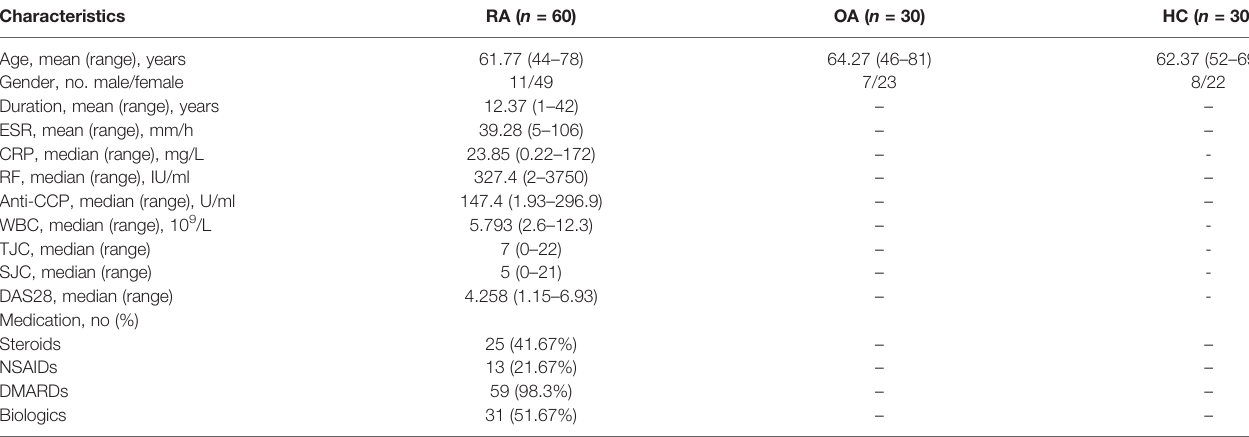
TABLE 1 | Clinical and laboratory characteristics of RA patients and controls in the study.